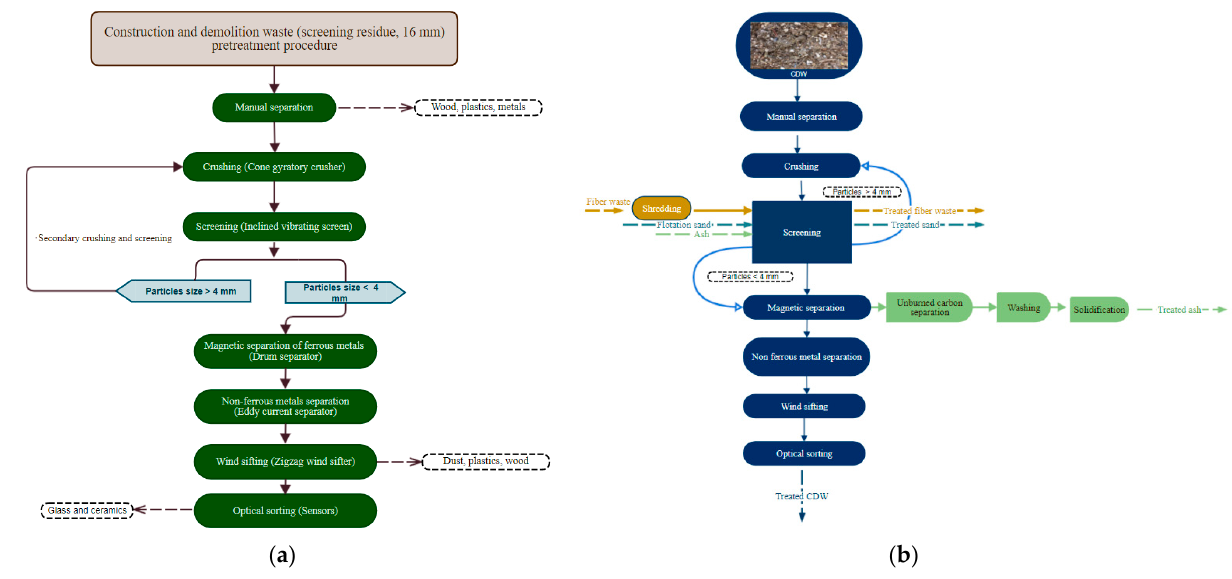
Figure 3. Pretreatment techniques and machines utilized for industrial waste: ( a ) pretreatment processes used for CDW; ( b ) combined line treatment for industrial side stream.